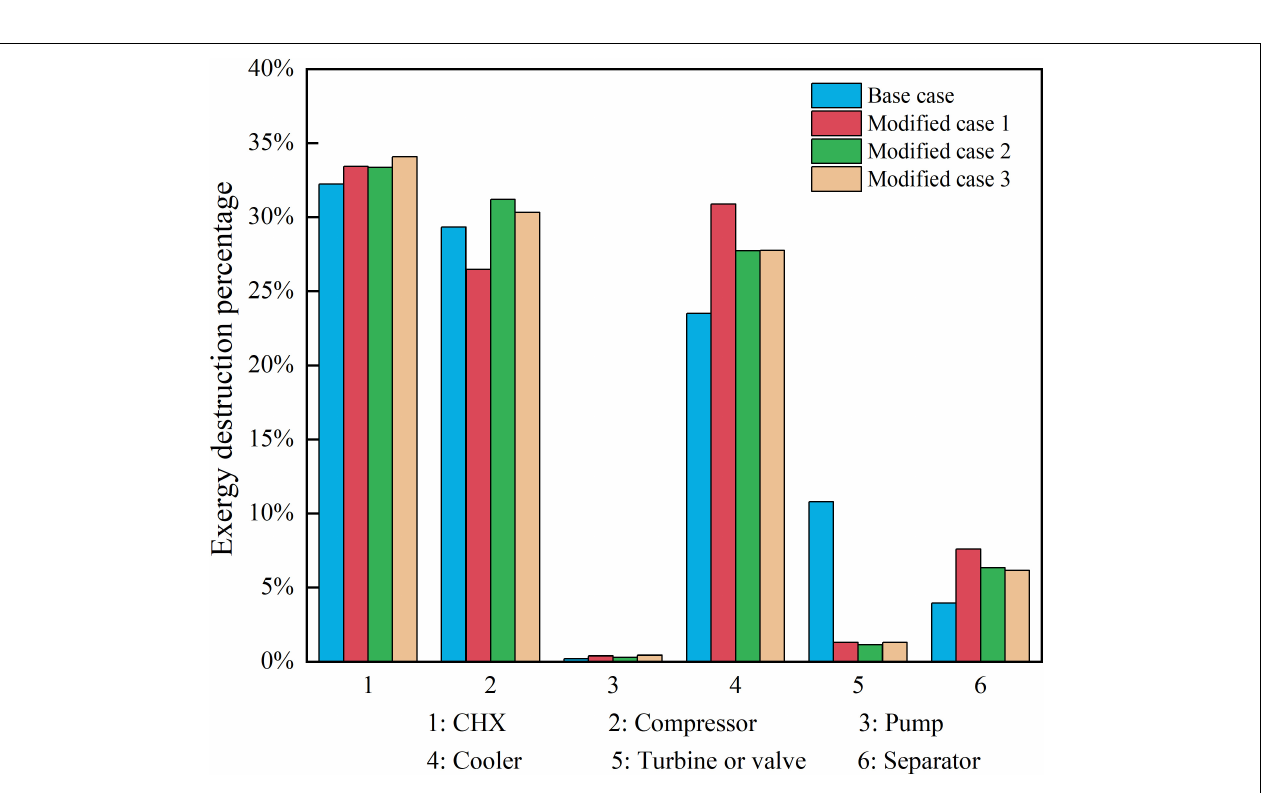
FIGURE 9 | The exergy destruction percentage of different equipment in four